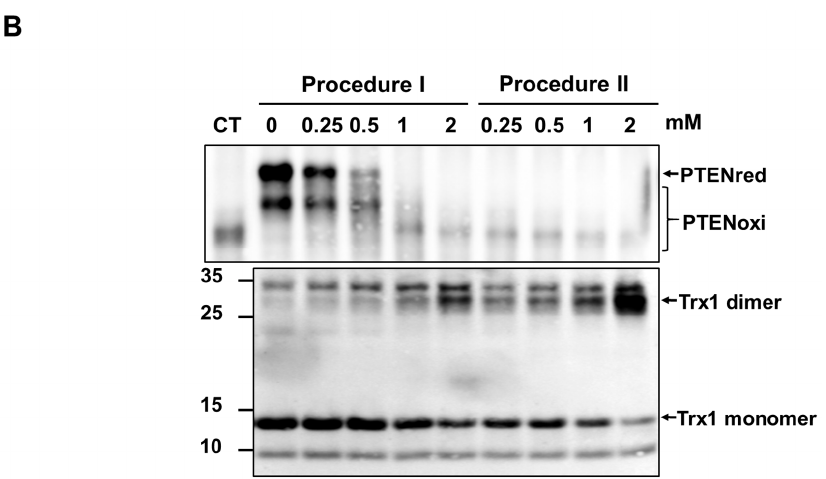
Figure 4. Effects of t -BHP on the reduction of oxidized PTEN by the Trx system. The experimental procedures are shown ( A ). PTEN and Trx1 were analyzed by non-reducing SDS-PAGE followed by immunoblotting ( B ). CT represents recombinant PTEN without any treatment.